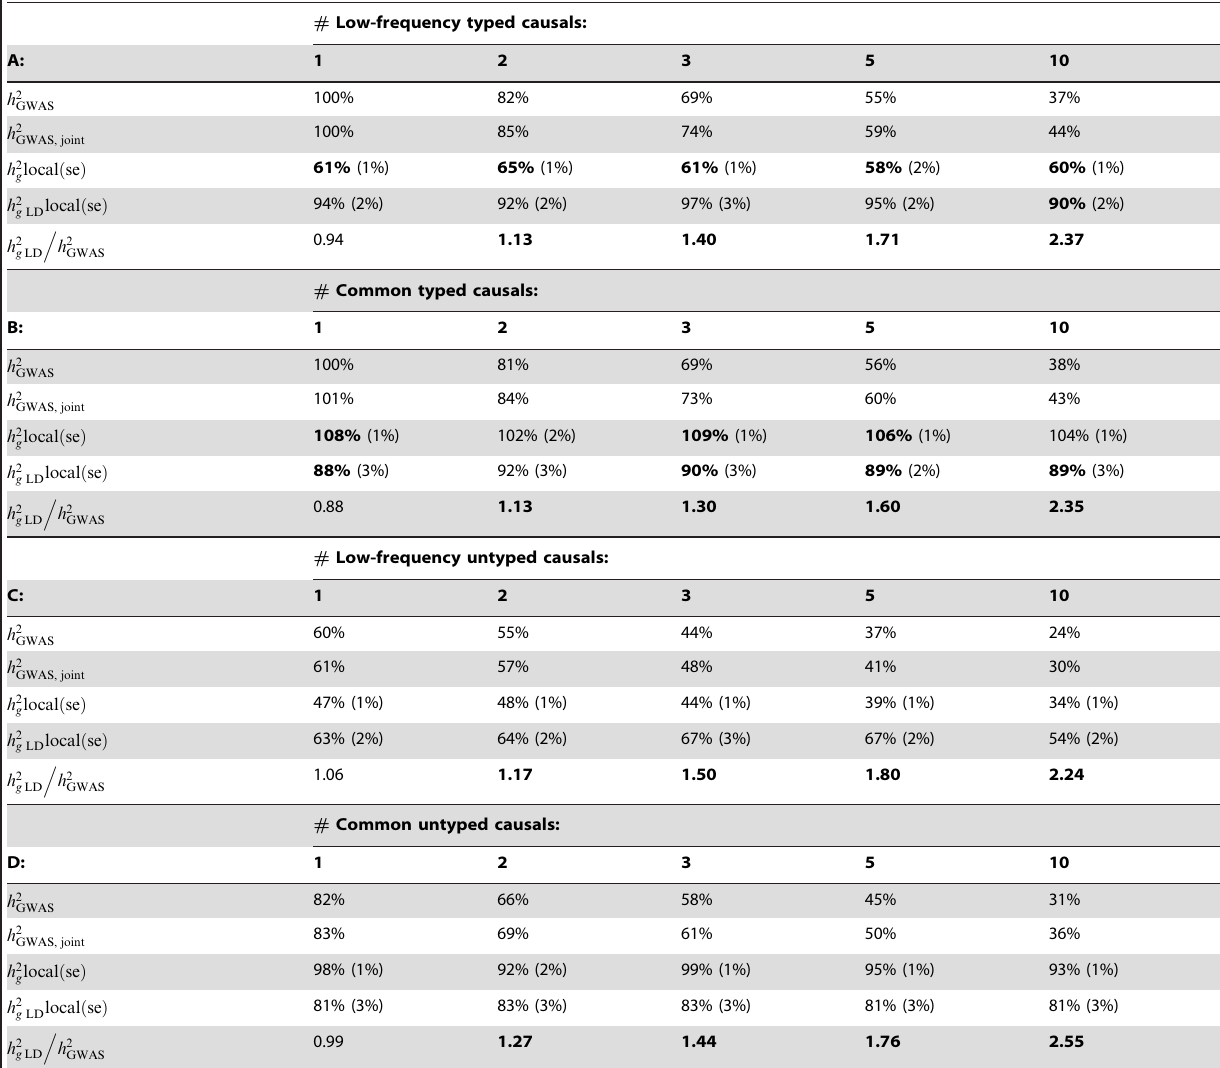
Analysis of simulated disease architecture with 180 causal 1Mbp loci yielding a true h 2 ~ 0 : 1 . In each locus, 1–10 causal variants were sampled from either low-frequency ( 0 : 01 v MAF v 0 : 05 ) of common (MAF w 0 : 10 ) WTCCC2 SNPs. For each of four methods tested, the fraction of local heritability identified by the method is reported over 50 simulations (with standard error in parenthesis). Top two panels correspond to experiments with observed causal variants and bottom two panels to experiments with causal variants hidden. In A and B only (where causals are typed), bold-faced h 2 g and h 2 gLD represents significant difference from 100% by z-score at P v 0 : 05 = 5 (accounting for 5 architectures tested). The ratio of h 2 gLD to h 2 GWAS is reported in the bottom row of each panel (with bold-face indicating significance by t-test at P v 0 : 05 = 5